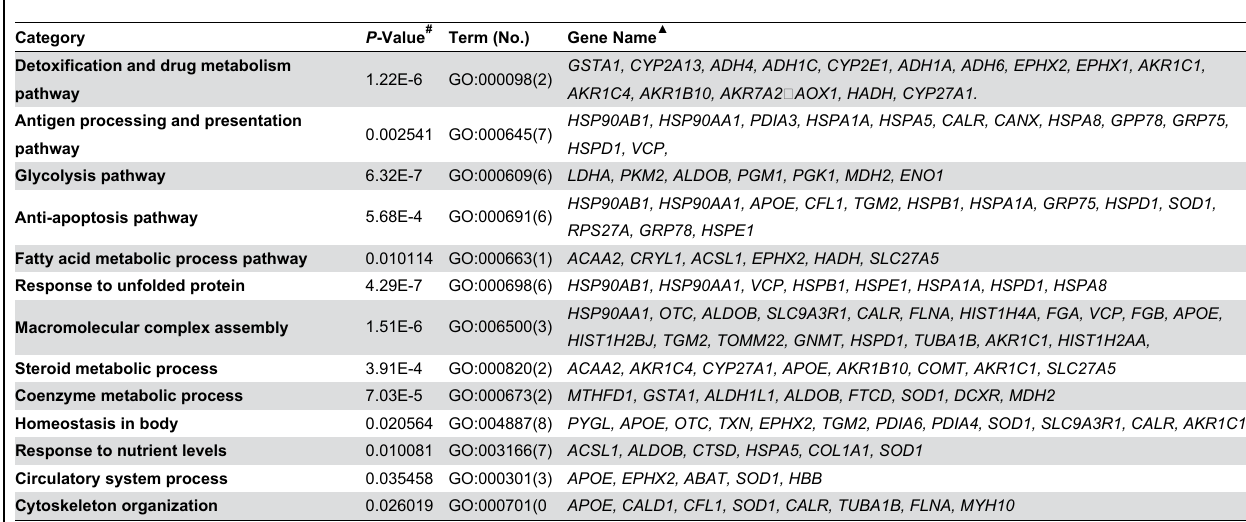
Table 4. Biological process categories of differentially expressed